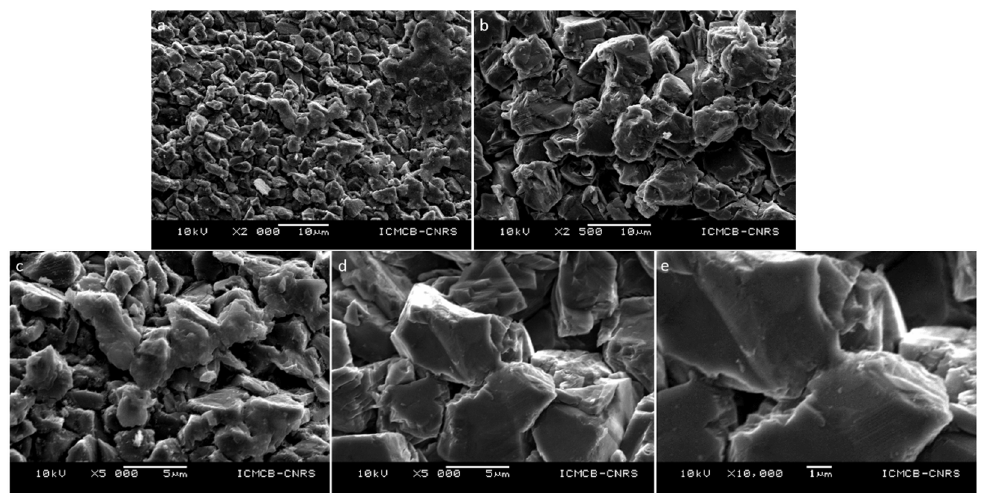
Figure 9. Microstructure of HP22-40-MS10 recovered sample observed in SEM (SEI, 10 kV , WD = 10 mm ) at different magnification (( a ) ×2000, ( b ) ×2500, ( c , d ) ×5000 and ( e ) ×10,000). There is no evidence for grain fracturation, nor the presence of other phases. Due to larger grain size, there are less areas sintered ( a , b ). However, in these areas, it is evident that grains boundaries are formed or in the process of formation ( c – e ).